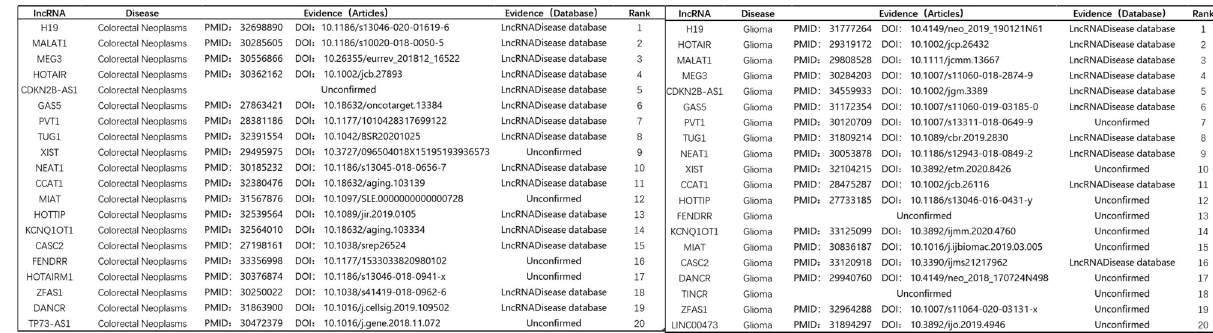
Figure 7. Validation results of lncRNAs predicted to be associated with colorectal neoplasm (Left) and glioma